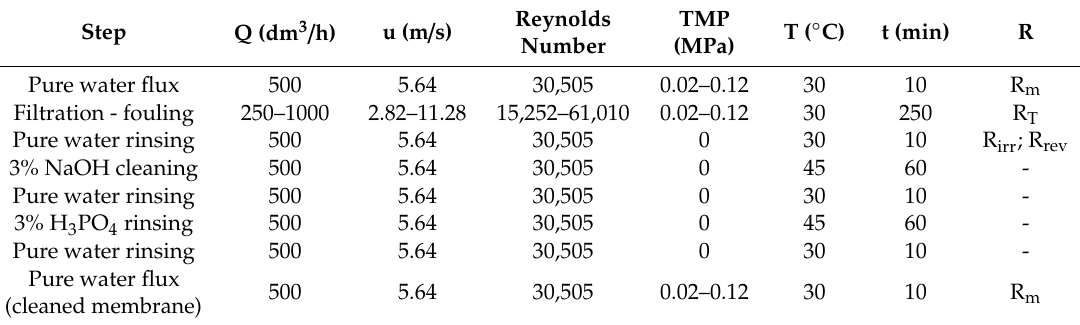
Table 1. Operating conditions for MF process and membrane